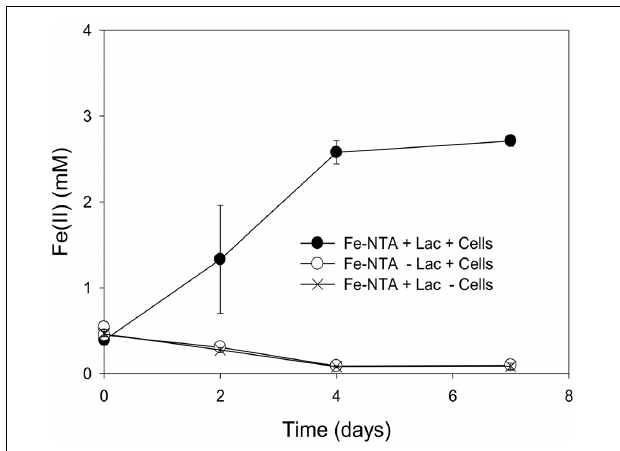
FIGURE 3 | Incomplete reduction of Fe(III)-NTA (10 mM) by “ P. lilae ” UFO1 in the presence of a fermentable substrate, 10 mM lactate after 7 days of incubation. Symbols are means of triplicate cultures, and error bars indicate ± 1 standard deviation.